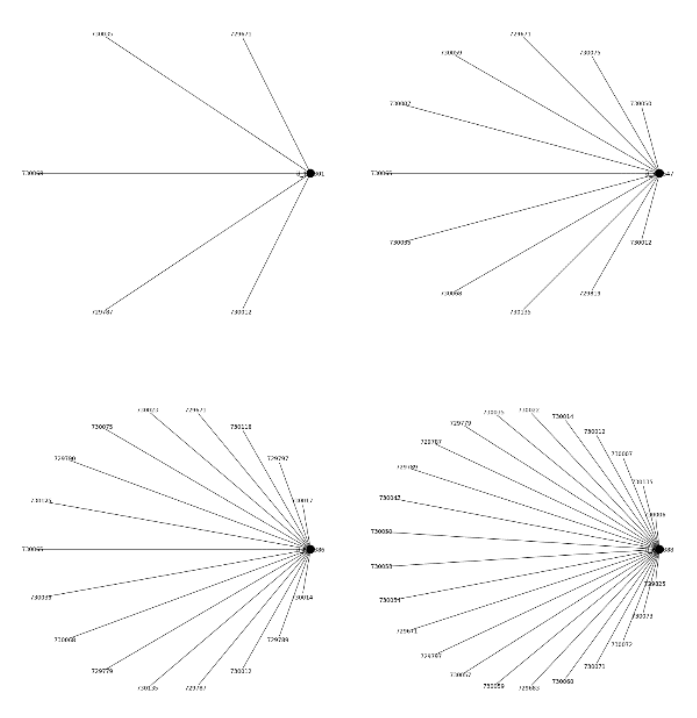
Samples of Constructed Social Networks Depicting Resources a Learner Interacted With